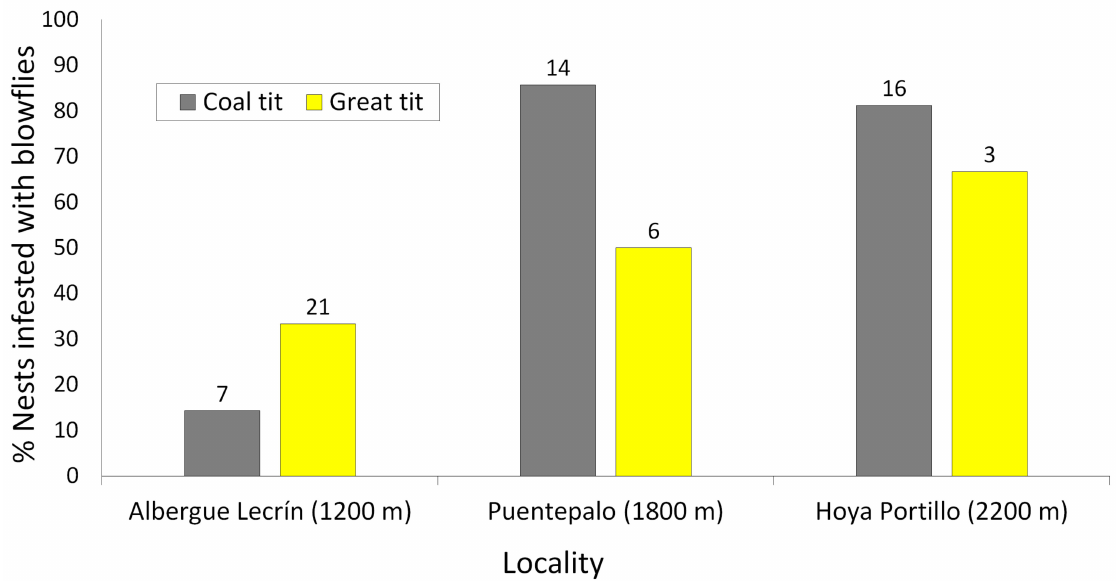
Figure 2. Percentage of coal tit (grey) and great tit (yellow) nests infested with blowfly larvae at each locality; the elevation is given in parenthesis. The numbers over bars indicate the sample size (number of nests